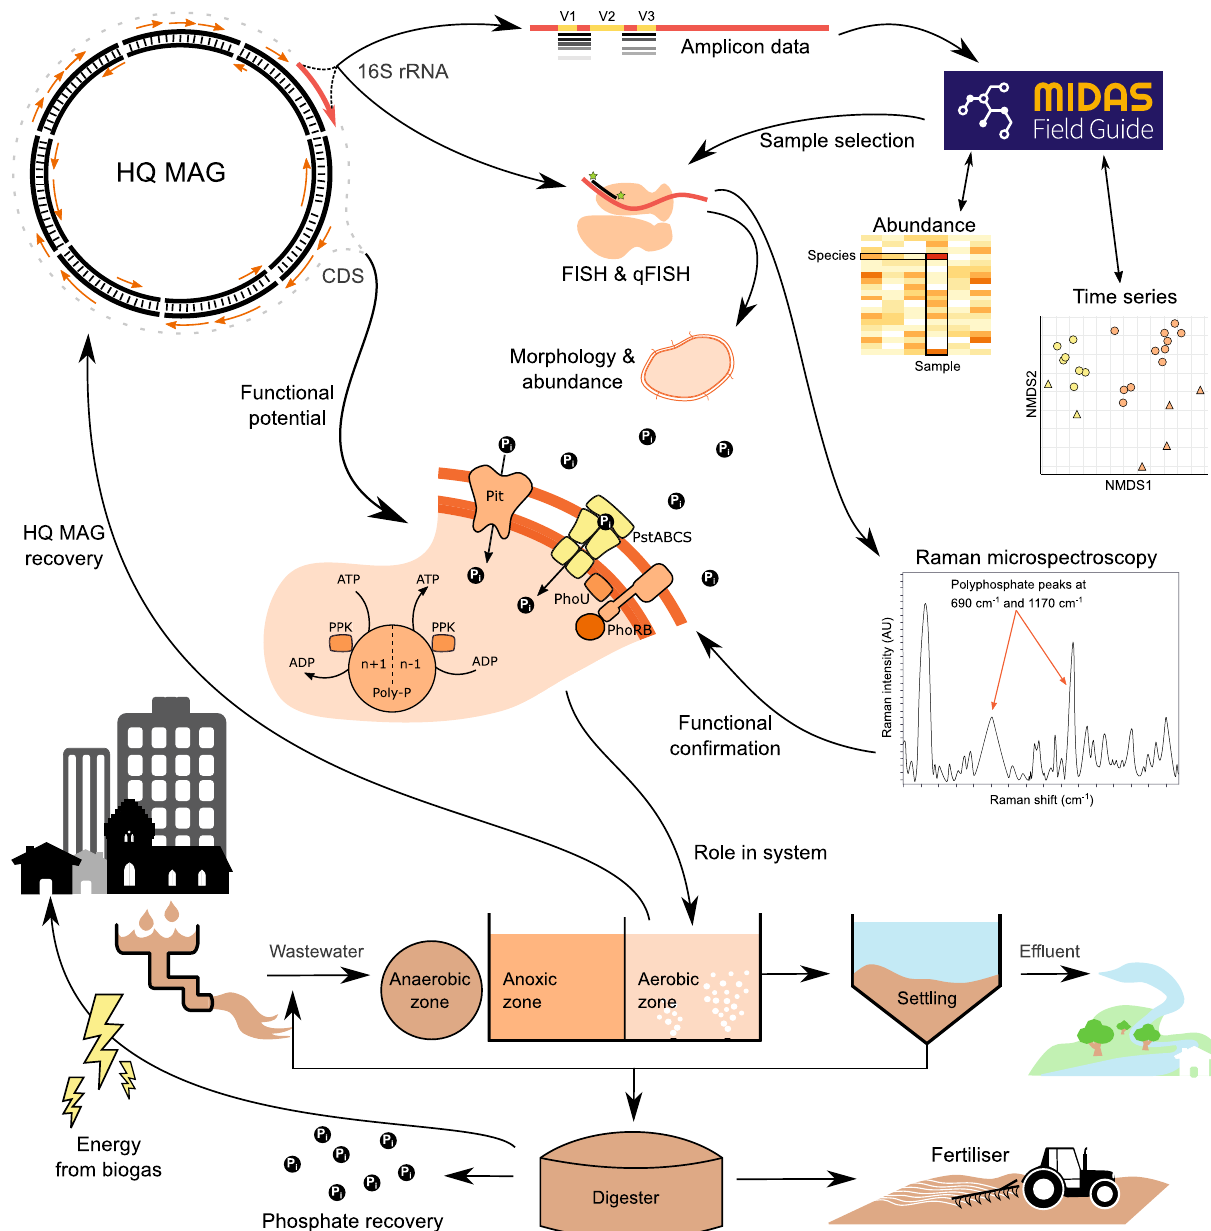
Fig. 1 Conceptual overview of the value of HQ MAGs in linking structure to function. HQ MAGs with full-length 16S rRNA genes are recovered from a full-scale AS sample, allowing linkage to the abundance and time-series data of MiDAS, and informing sample selection for further experiments. MAG and MiDAS full-length 16S rRNA gene sequences facilitate creation of lineage-speci fi c FISH probes. Abundance is con fi rmed with quantitative FISH (qFISH), and morphology and location in the fl oc is determined. The coding sequences (CDSs) provide information on functional potential, such as the presence of phosphate accumulation enzymes (e.g., PstABCS, Pit, and PPK), allowing for the selection of novel species that may belong to certain functional guilds. Speci fi c potential pathways, such as polyphosphate accumulation, can be experimentally determined with Raman microspectroscopy in combination with FISH and the information gained from the full-length 16S rRNA gene. This leads to con fi rmation of the population ’ s role in the AS system and uncovers targets for investigation into improved resource recovery and effective wastewater